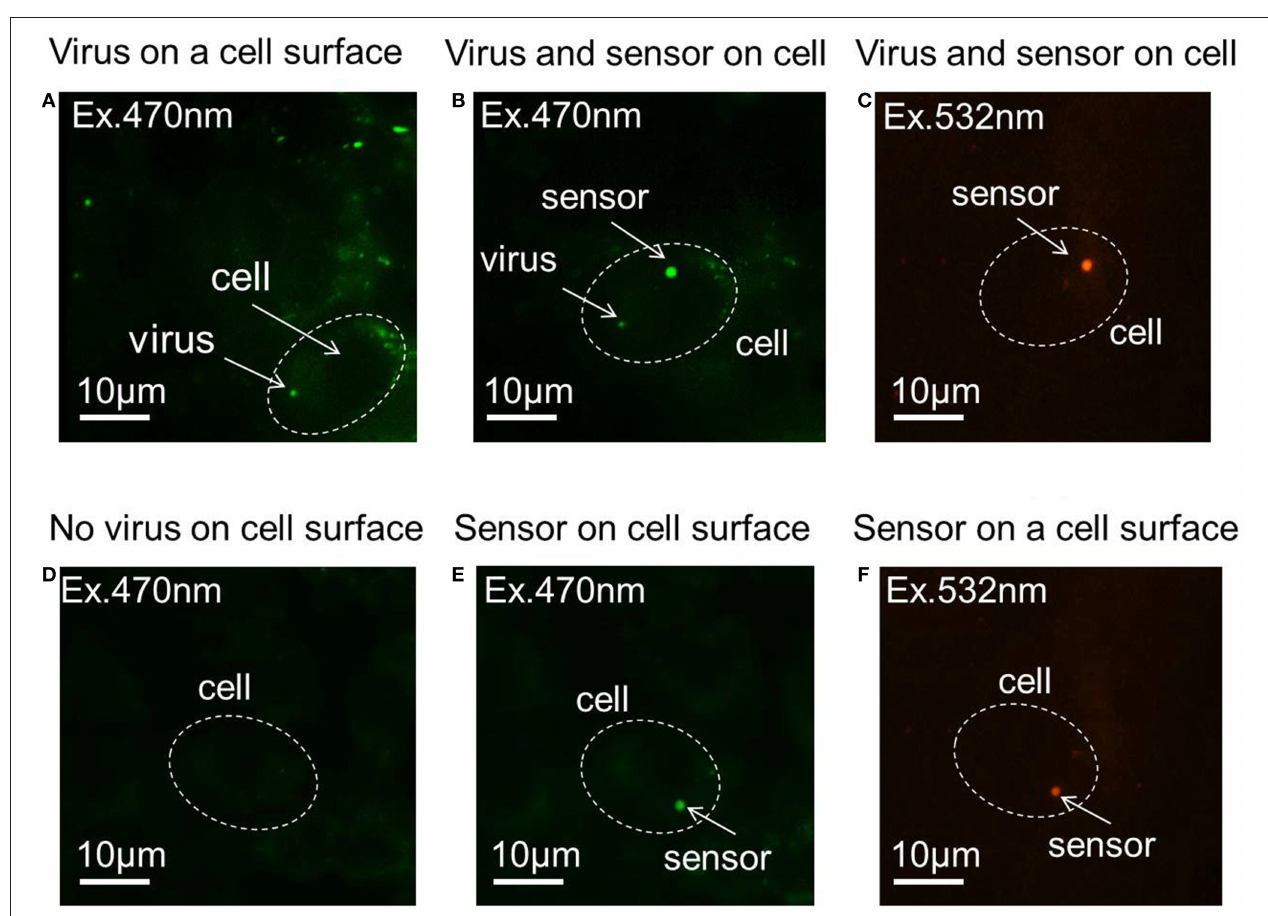
FIGURE 2 | Fluorescence images of the pH sensor and virus on the cell membrane. (A) Virus adhered to the cell surface. (B) A pH sensor adhered to the same cell with a virus on its surface, with an excitation of 470nm laser. (C) A pH sensor adhered to the same cell with a virus on its surface, with an excitation of 532nm laser. (D) Virus-unbound cell. (E) A pH sensor adhered to a virus-unbound cell, with an excitation of 470 nm laser. (F) A pH sensor adhered to a virus-unbound cell, with an excitation of 532 nm laser.